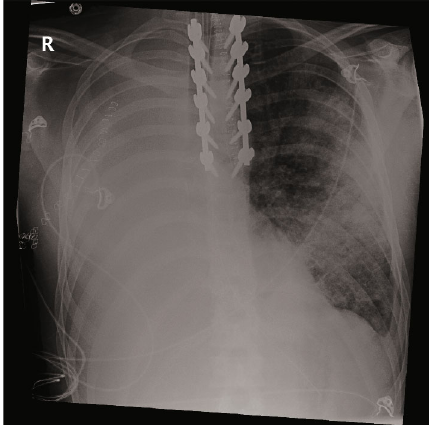
Figure 2: Chest radiograph on post-operative day #11.